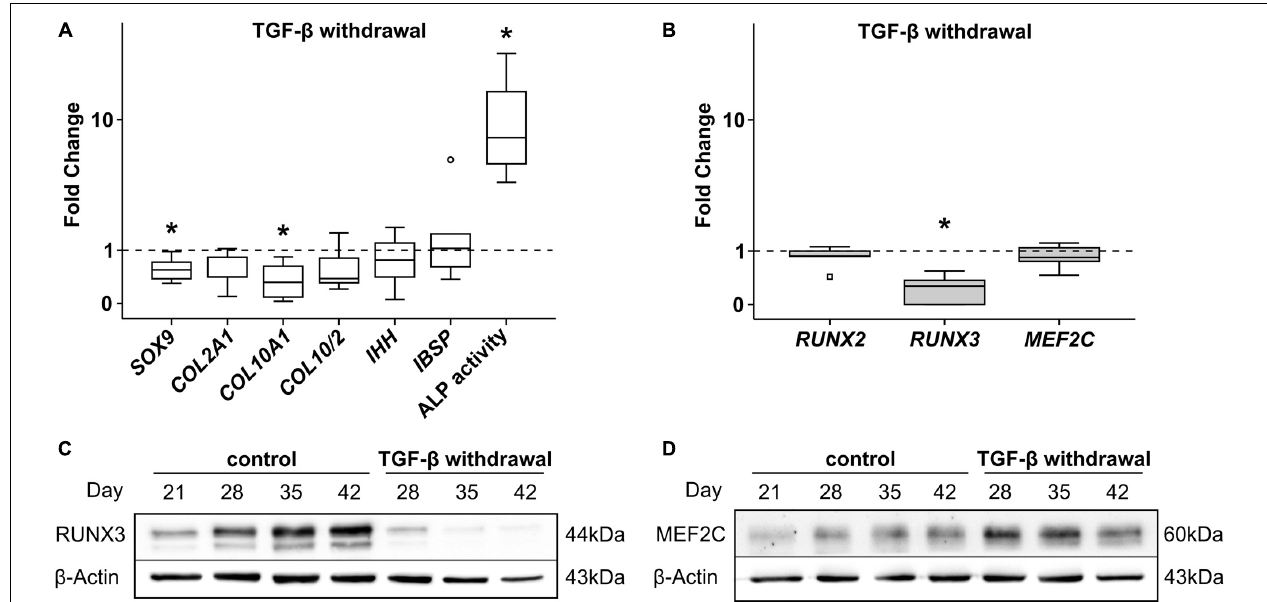
FIGURE 4 | Effects of TGF- β withdrawal on RUNX2, RUNX3, and MEF2C. MPC pellets were subjected to chondrogenic induction for 3 weeks before TGF- β was omitted from chondrogenic medium for half of the pellets, while other ingredients remained constant until week 6 ( n = 5 donors). Expression of indicated genes was determined at day 42 by qPCR (A,B) , and levels were referred to reference genes HNRPH1 and CPSF6 . ALP activity was quantified in culture supernatants ( n = 4 donors) (A) . Expression levels of indicated genes and ALP activity are referred to control cultures (dashed lines). Box plots were generated as described in Figure 1 , outliers are depicted as ◦ , and extreme values as (cid:3) . *, p ≤ 0.05, Mann–Whitney U test compared to control. (C) RUNX3 and (D) MEF2C protein levels were determined by Western blot analysis, β -actin levels were determined as internal reference. One representative of three experiments is shown.